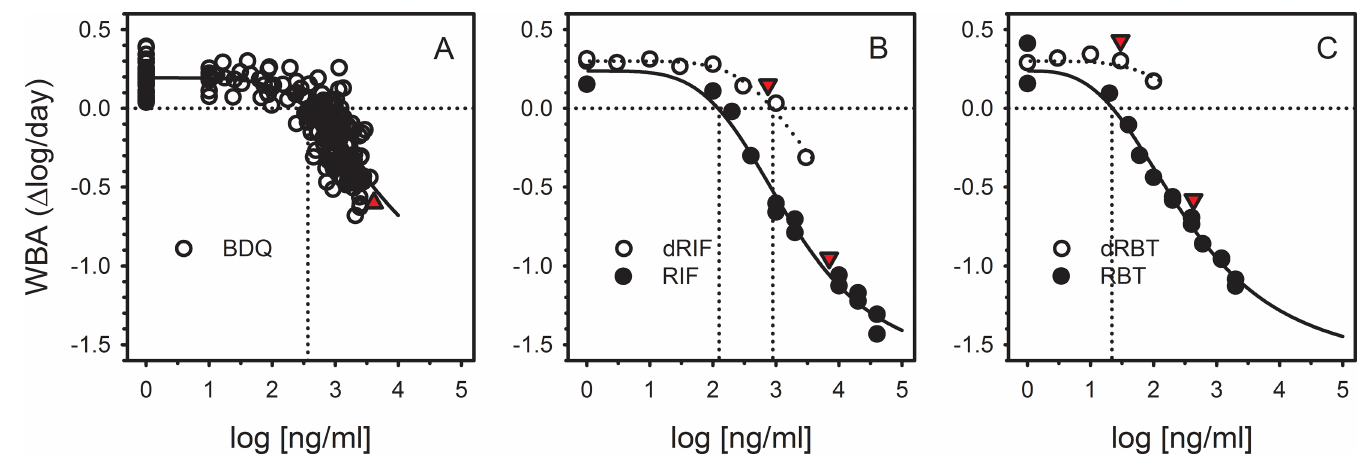
Fig 3. Relationship between drug concentration and whole blood bactericidal activity (WBA) for bedaquiline (panel A), rifampin (panel B), and rifabutin (panel C). Panels B and C also indicate activity of desacetyl rifamycin metabolites (open circles). All drug concentrations reflect those in whole blood culture. For bedaquiline, measured plasma concentrations were reduced by a factor of two to account for dilution with tissue culture medium in whole blood culture. Rifamycins and their metabolites were added directly to whole blood cultures at the indicated concentrations. Red triangles indicate plasma Cmax values, which have also been adjusted to account for dilution in whole blood culture. Vertical dotted lines indicate concentrations required for intracellular mycobacteriostasis (zero WBA).